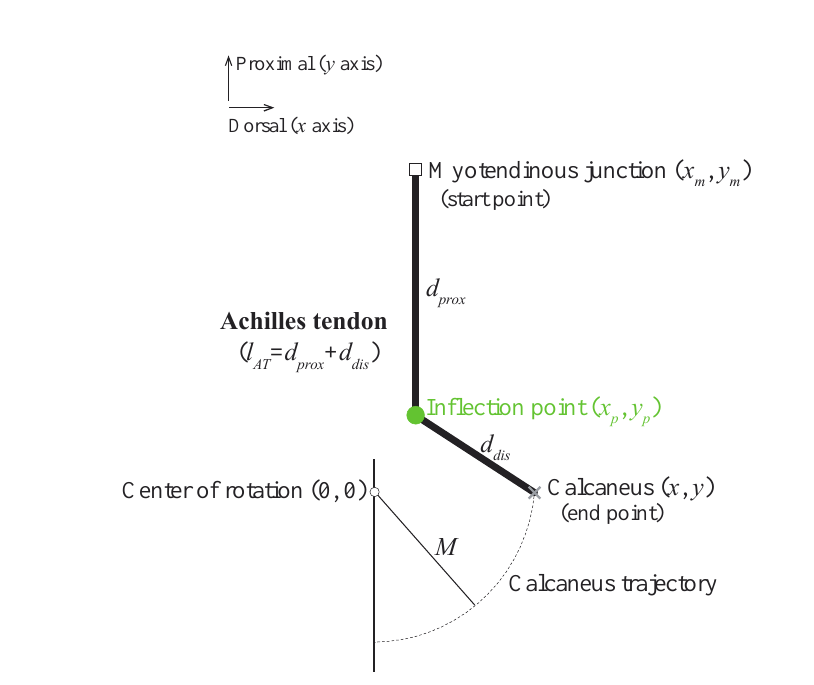
Figure 1. Simplified ankle model with the presence of an inflection point. The inflection point prevents the Achilles tendon from moving dorsally. The arc indicates the trajectory of the calcaneus during ankle joint rotation. Radius M is the distance from the ankle center of rotation to the insertion of the Achilles tendon on the calcaneus (i.e., inferior calcaneal tuberosity, grey cross symbol). Distance d dis is the length of the segment from the inflection point to the insertion of the Achilles tendon on the calcaneus, whereas d prox is the length of the segment from the myotendinous junction to the inflection point. The Achilles tendon length l AT is defined as the sum of the distances from the myotendinous junction to the inflection point and from the inflection point to the calcaneus. We considered different coordinates for the inflection point within a physiological range along the x and y axes during the ankle joint rotation (Figure 2). The physiological range of the Achilles tendon was defined as the area within the Achilles tendon and represented the area of a quadrilateral comprising four sides and four vertices. The upper right and left points are on the same horizontal line as the myotendinous junction location and are positioned on the most dorsal and ventral edges of the Achilles tendon. The lower right and left points are on the same horizontal line as the most distal end of the Kager’s fat pad and are positioned on the most dorsal and ventral edges of the Achilles